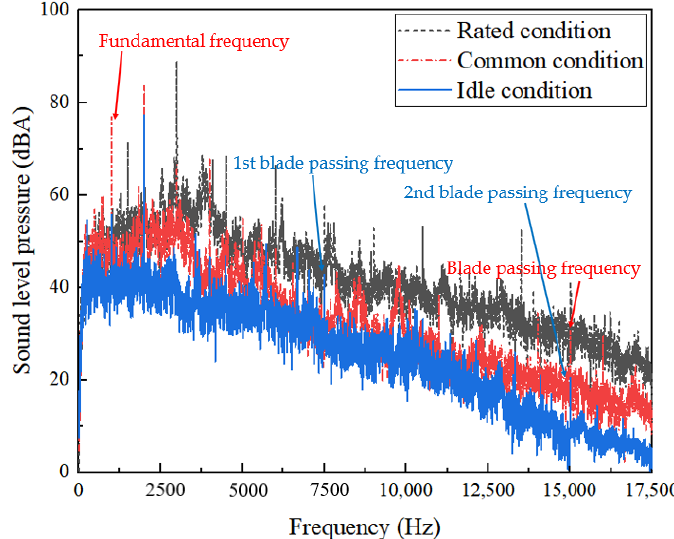
Figure 5. Near-field noise spectrum characteristics under different working conditions.